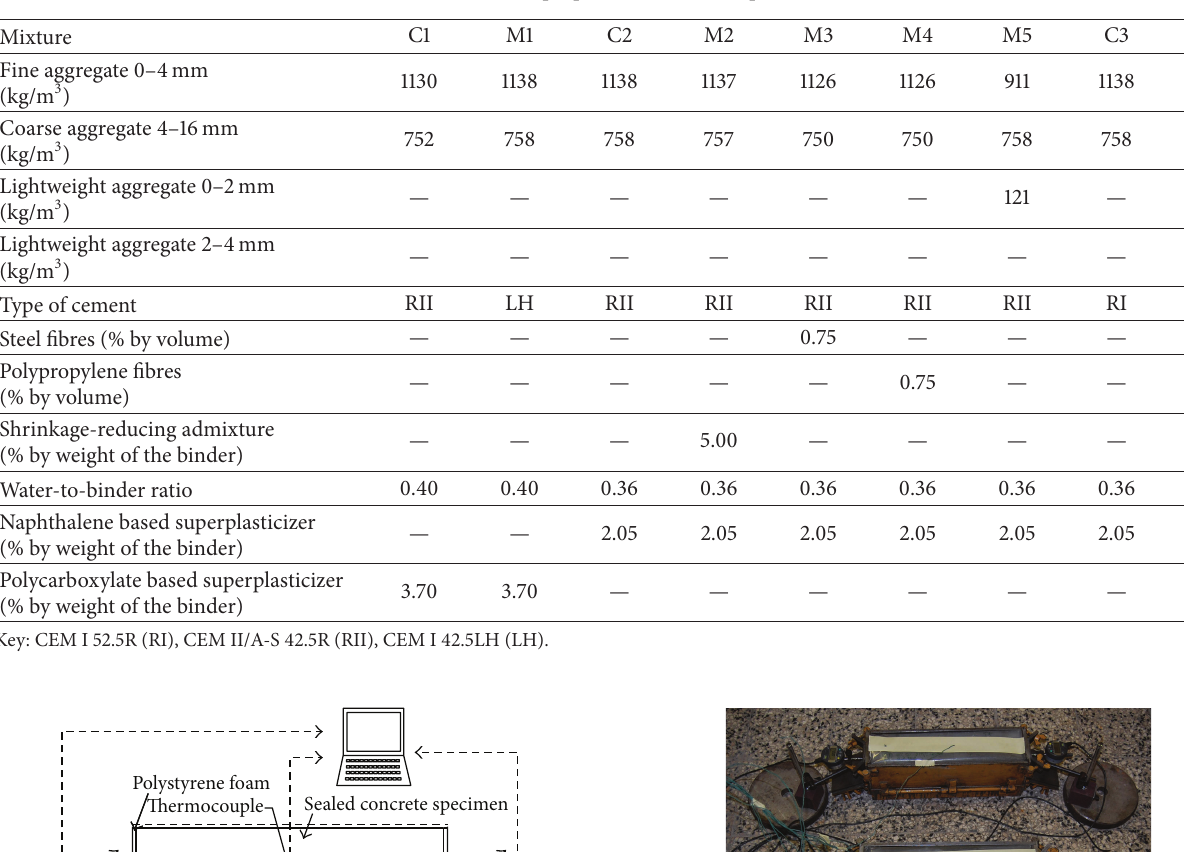
Table 4: Mix proportions of the composites.